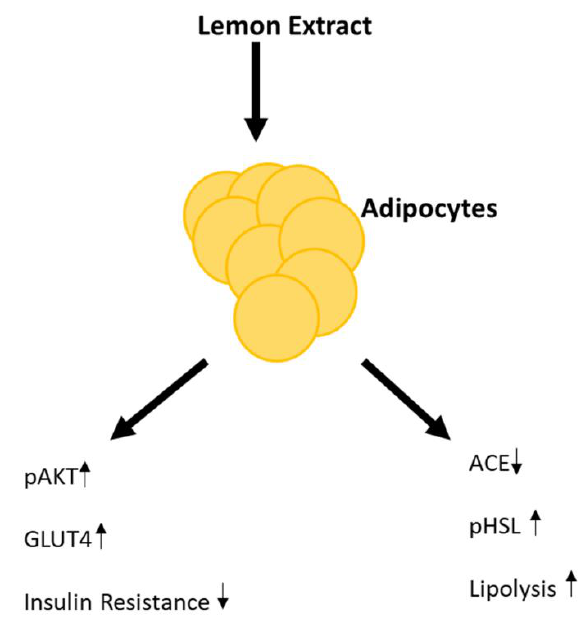
Figure 6. Proposed mechanism in which lemon extract (LE) induces insulin sensitivity and lipolysis in adipocytes. ↑ - upregulation and ↓ - downregulation.